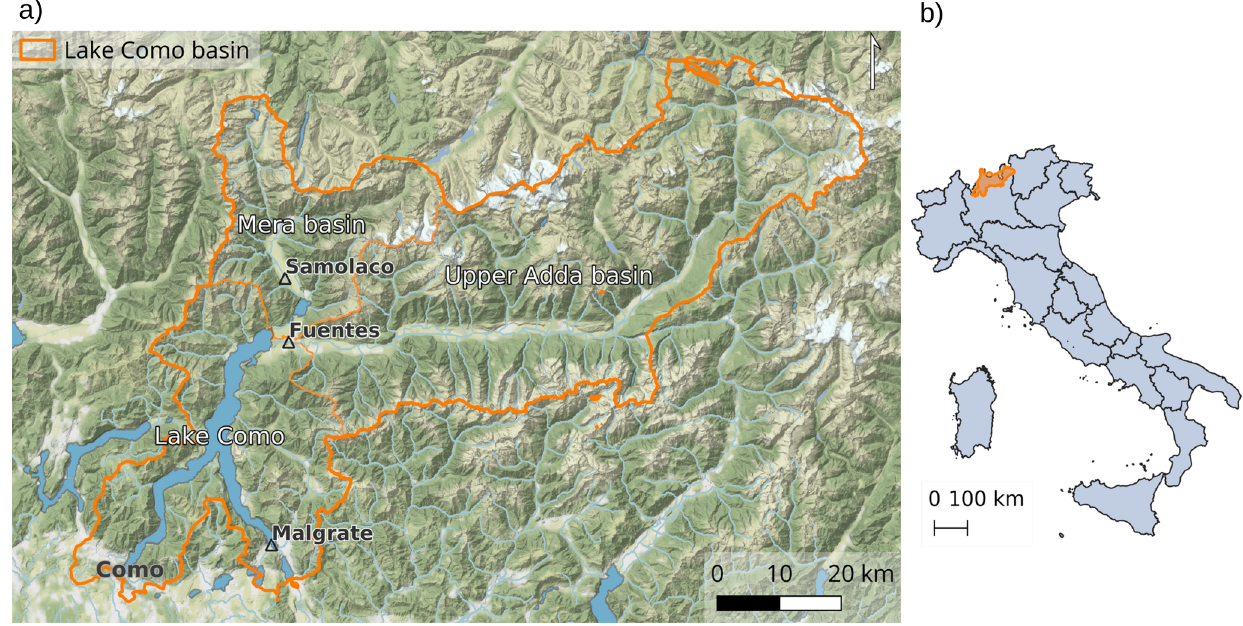
Fig. 1 Study area. a Lake Como and its drainage area. The main sites and gauges' locations named in the paper are also reported. Source of the basemap: map tiles by Stamen Design, under CC BY 3.0, and data by OpenStreetMap, under ODbL. b Location of Lake Como basin in Italy. The boundaries of the